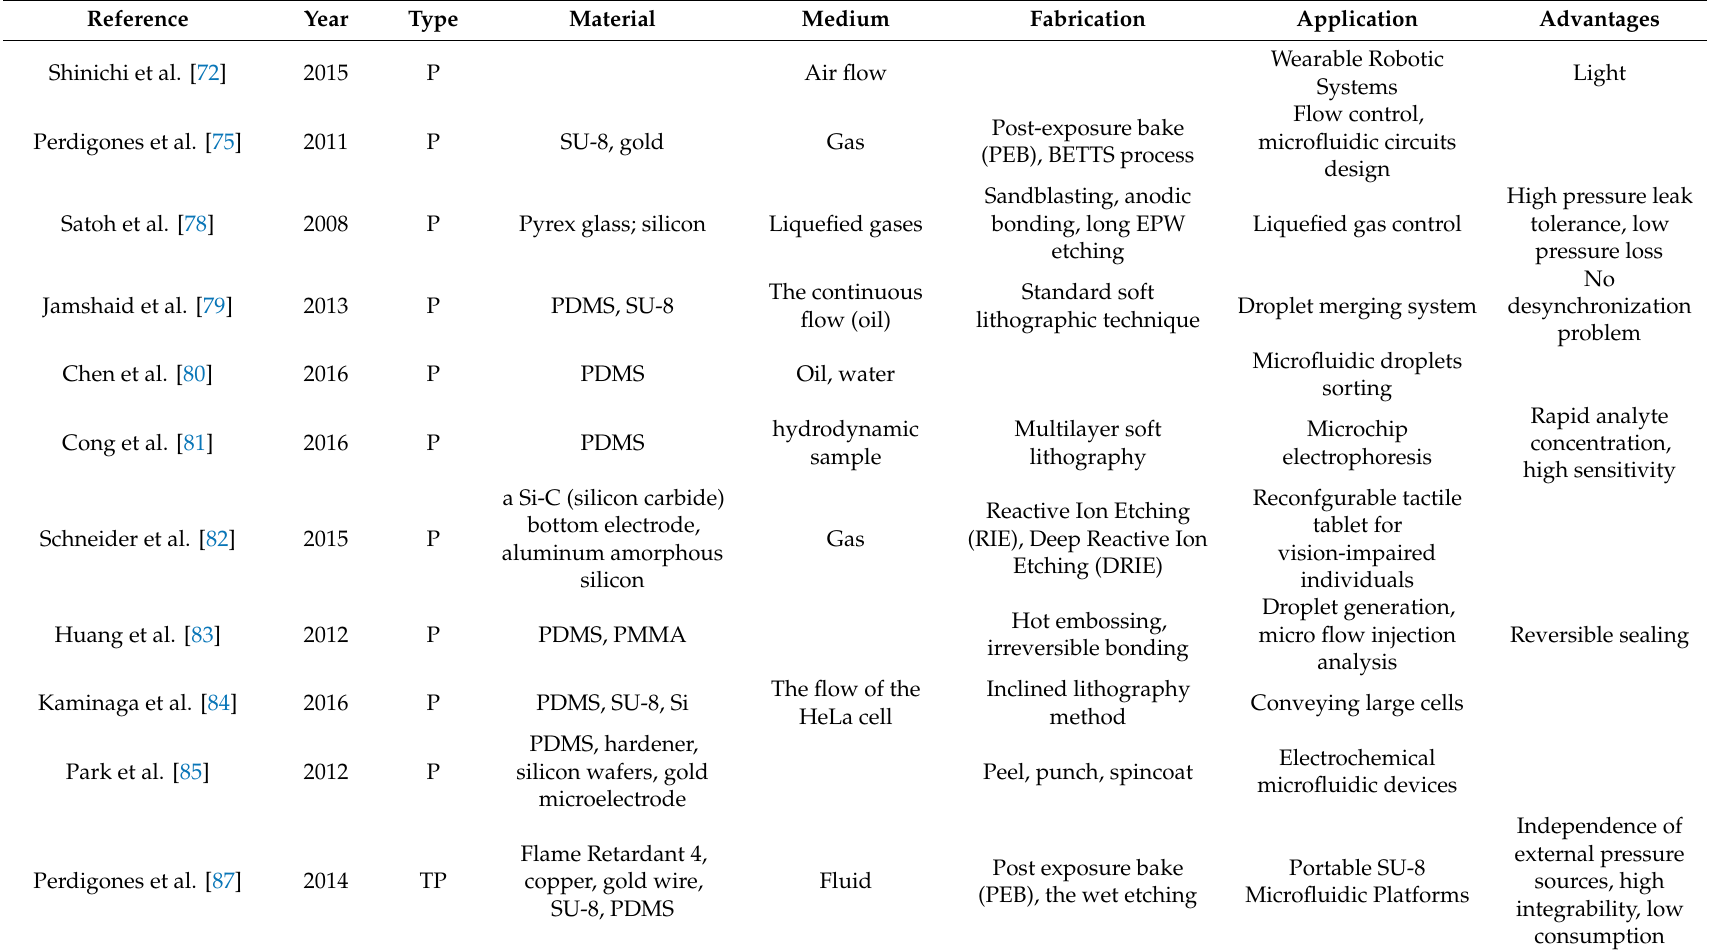
Table 5. Summary of microvalves based on pneumatic actuation and thermopneumatic actuation. P: Pneumatic; TP: